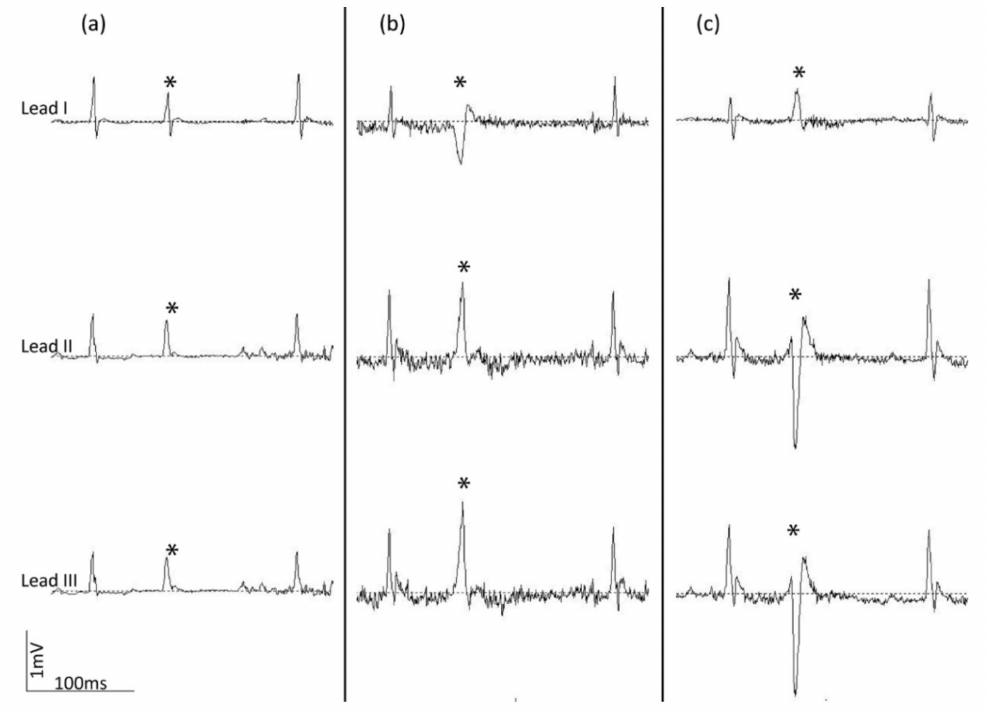
Figure 8. Representative ectopic beats recorded in mice using lead I, II and III configurations. ( a ) An ectopic beat with either an atrial or junctional origin, based on a narrow QRS complex; ( b , c ) ectopic beats with origin in the ventricles (based on a broad QRS complex); for ( b ) an inferior axis and for ( c ) a superior axis can be inferred based on the ECG pattern. Vertical and horizontal scale bars represent 1 mV and 100 ms, respectively. Ectopic beats are indicated with